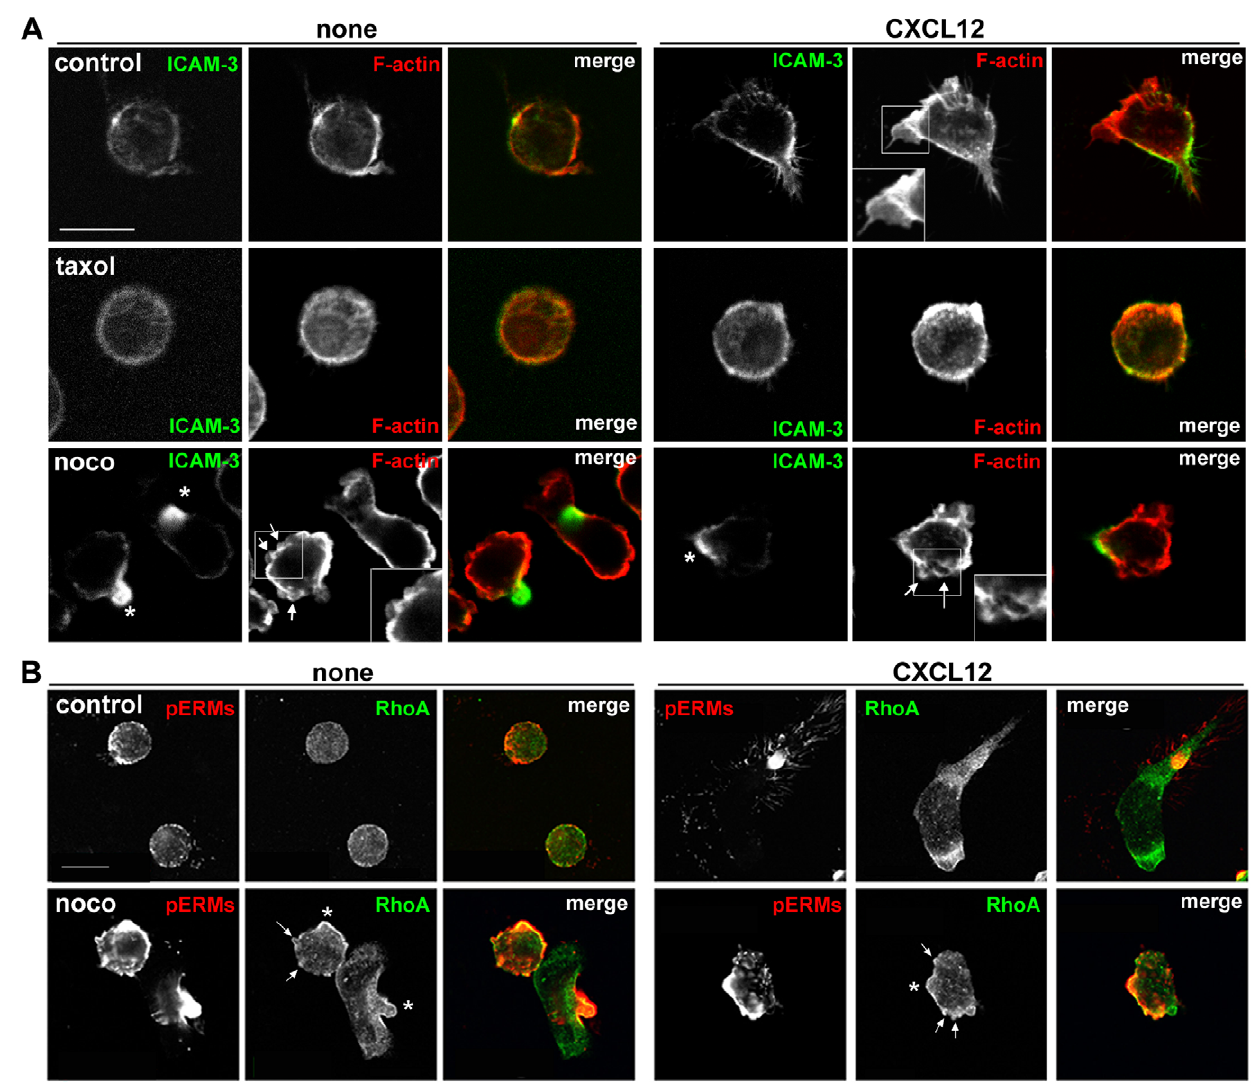
Figure 4. Microtubule-disrupting agents do not affect polarized clustering of uropod proteins. CCRF-CEM cells were pre-treated with or without 10 m M taxol for 30 min or 20 m M nocodazole for 10 min, plated on ICAM-1, and then stimulated with 20 nM CXCL12 for 5 min before fixation. (A) Cells were stained with anti-ICAM-3 antibody (green) and phalloidin to show actin filaments (red). Small uropod-like protrusions where ICAM-3 accumulates in nocodazole-treated cells are indicated with white asterisks. Representative confocal images are shown. (B) Cells were stained with anti-RhoA antibody (green) and anti-phospho-ERM antibody (red). Bleb-like membrane protrusions are indicated with white arrows and small uropod-like protrusions where brighter phospho-ERM staining is observed are shown with white asterisks in nocodazole-treated cells. Bar=10 m